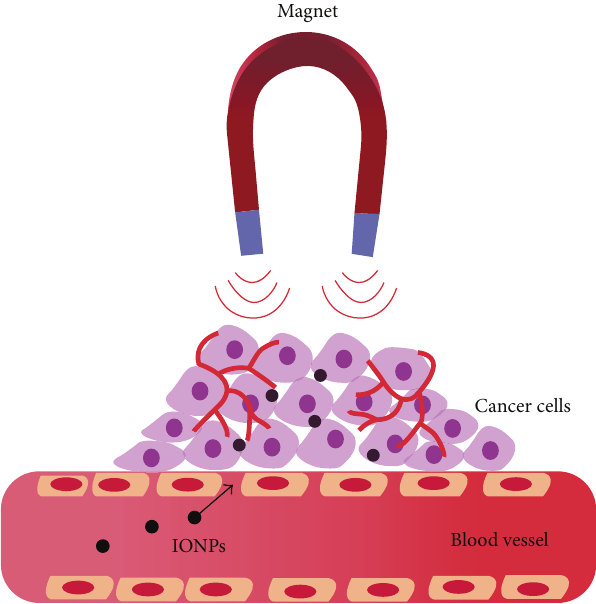
Figure 1: Schematic representation of magnetic drug targeting